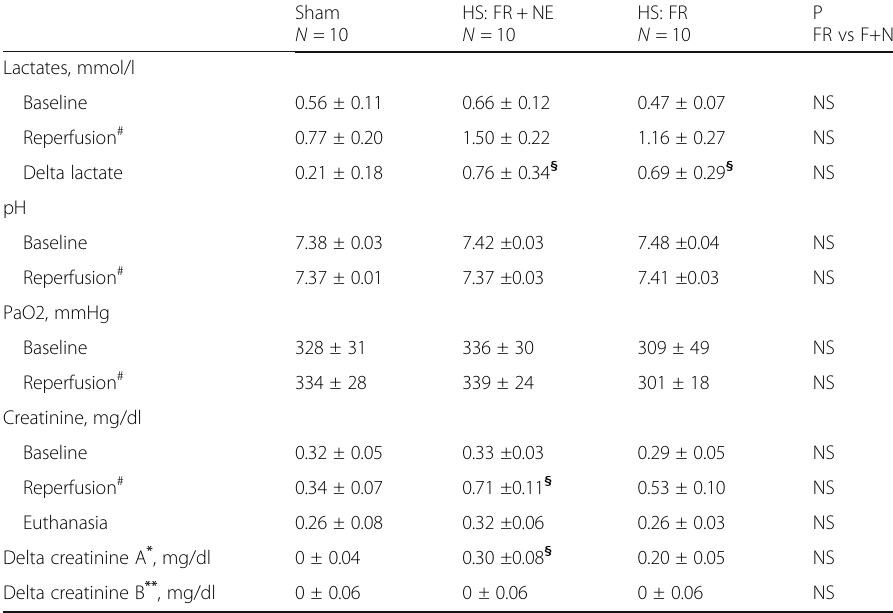
Table 2 Physiological parameters measured